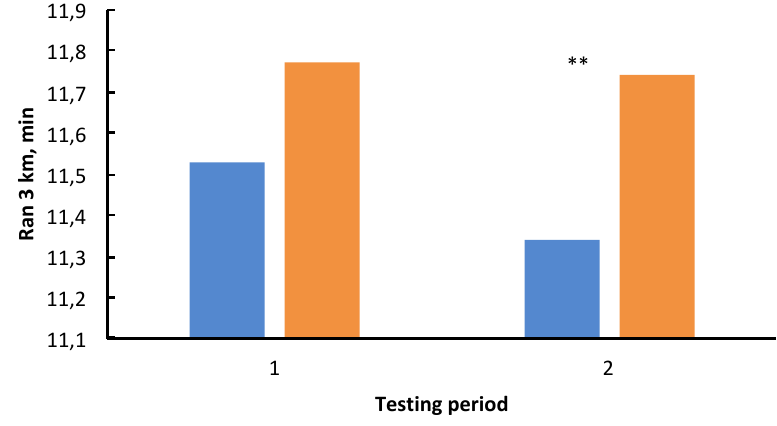
Fig. 2. Results of the test “3 km run” by athletes of the experimental and the control groups before and after the experiment: